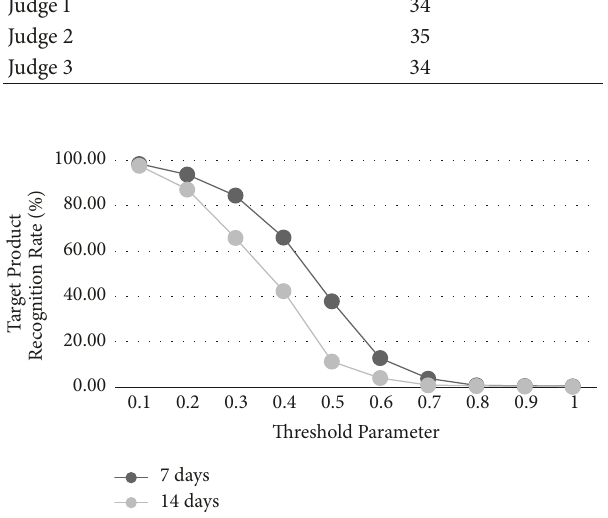
Figure 4: The influence of threshold parameters on the recognition rate of target